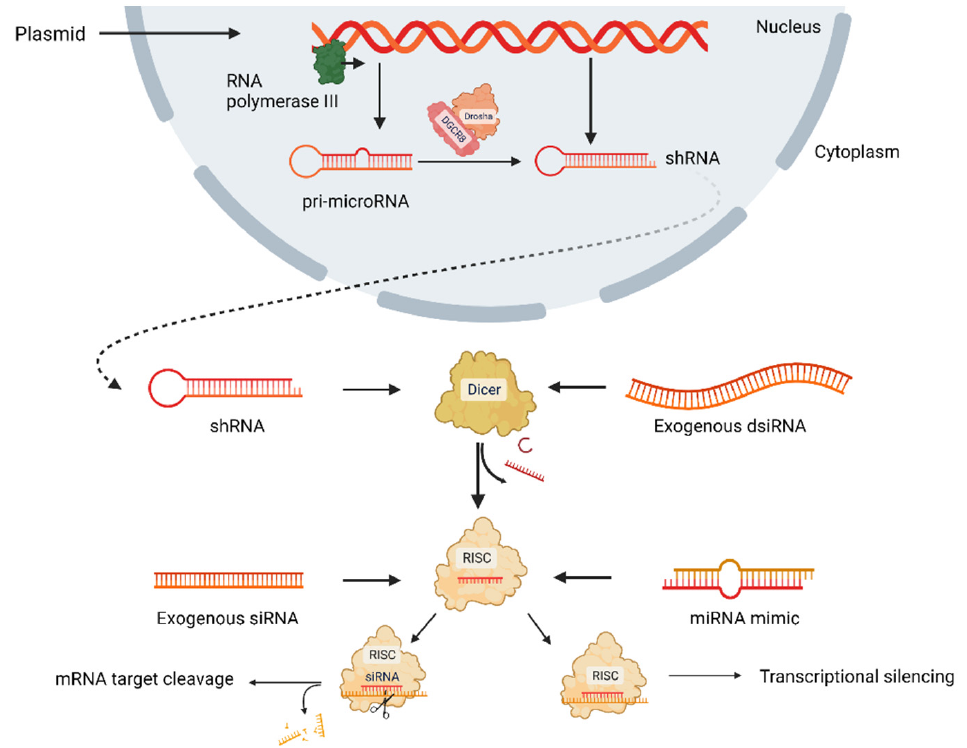
Figure 1. RNA interference pathways. The upstream process starts with short hairpin RNA (shRNA) or pri-microRNA (pri-miRNA) addition, which requires nuclear processing, followed by transportation into the cytoplasm. Upon arrival, shRNA and Dicer substrate RNA (dsiRNA) are digested into short interfering RNA (siRNA) or microRNA (miRNA). To produce siRNAs, the dicer enzyme cleaves double-stranded RNA (dsRNA) sequences into small double-stranded siRNA, and RISC elements transport them to mRNA targets that recognize guide-stranded RNA (gsRNA), which results in mRNA cleavage and degradation. In the process of microRNA (miRNA) delivered into cytoplasm, RISC binds this target sequence, which results in translational repression and successive segregation into p-bodies for degradation [12–14,18]. Adapted from “RNAi mechanism”, by BioRender.com (2022). Retrieved from https://app.biorender.com/biorender-templates. Here, we mainly focus on the lentiviral gene delivery RNAi approach and its effective- targets and to show the effectiveness of gene-silencing therapy in osteosarcoma